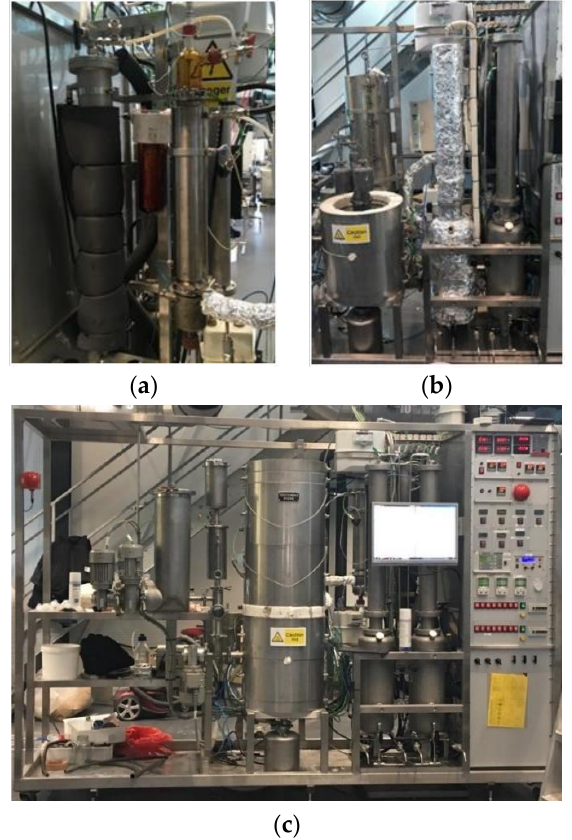
Figure 2. Fast Pyrolysis experimental setup: ( a ) ESP configuration , ( b ) Spray condensers route , ( c ) Pilot unit overview.